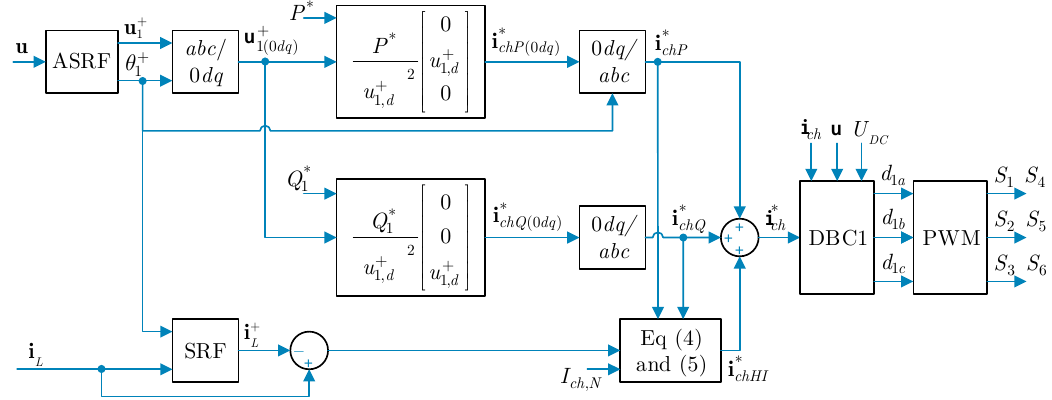
Figure 3. Block diagram of the three-phase VSI control Figure 3 . Block diagram of the three-phase VSI control system.